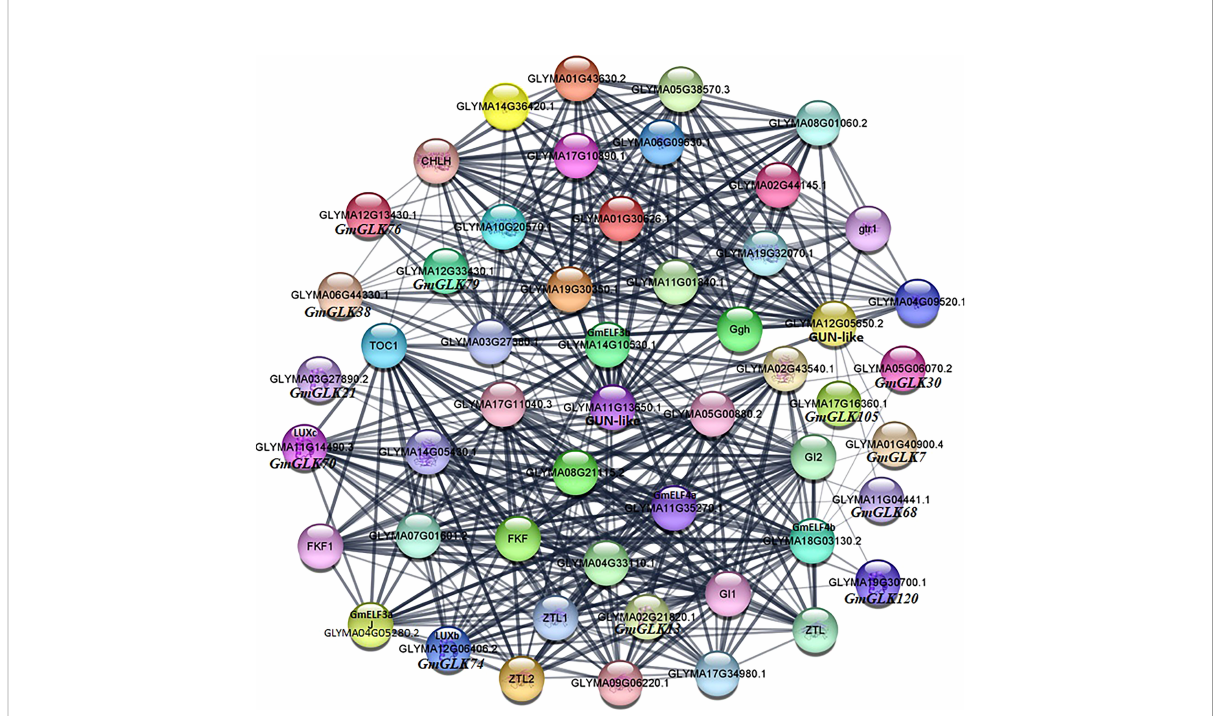
FIGURE 8 Co-expression networks of GmGLK proteins in soybean. The nodes indicate distinct proteins, whereas the edges indicate the interaction across proteins. The width of the edge representing the strength of the